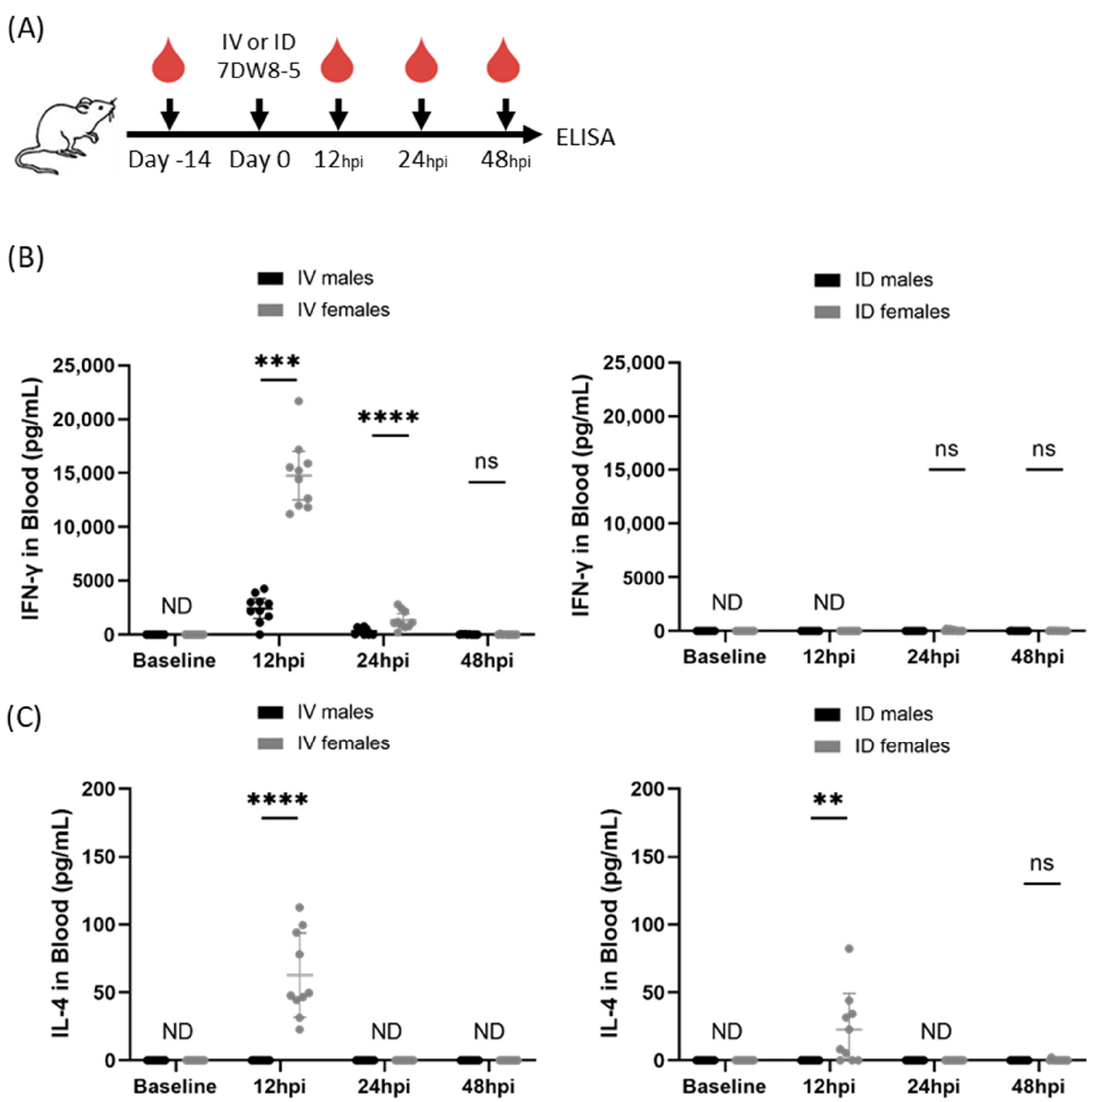
Figure 1. 7DW8-5 induces higher levels of systemic IFN- γ and IL-4 in female vs. male BALB/cJ mice. ( A ) Experimental design of blood plasma ELISA studies. IFN- γ ( B ) or IL-4 ( C ) cytokine levels induced by IV-7DW8-5 ( left ) or ID-7DW8-5 ( right ) in mouse blood plasma. Female IV data adapted from Watson et al. for comparison [12]. Error bars represent the SD of the mean of N = 10 BALB/cJ mice across two independent experiments. ELISA data analyzed with Mann–Whitney Tests, **** p < 0.0001, *** p < 0.001, ** p < 0.01, ns p > 0.05. ND = Not detected. ID = two 10 µ L injections for all.